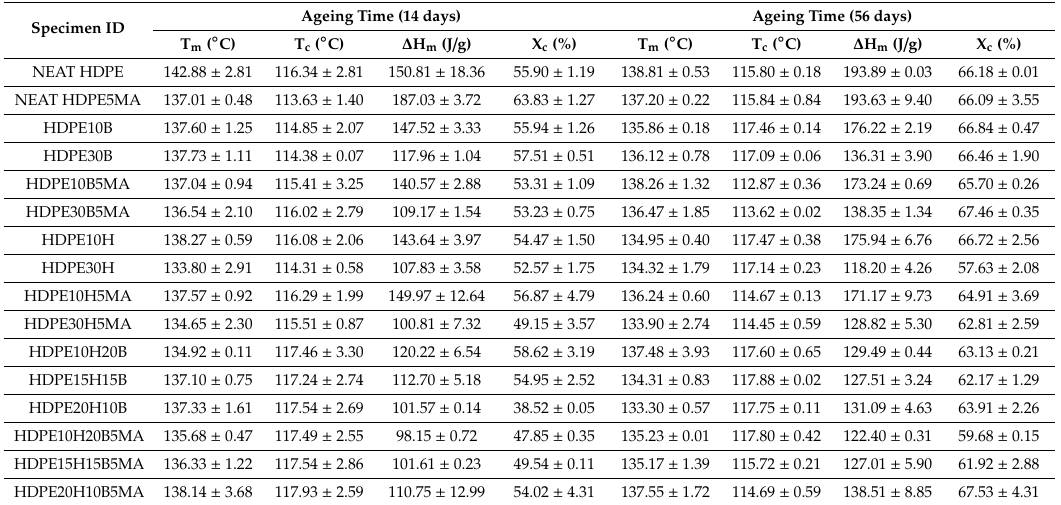
Table 4. Thermal properties of composites obtained from di ff erential scanning calorimetry (DSC)